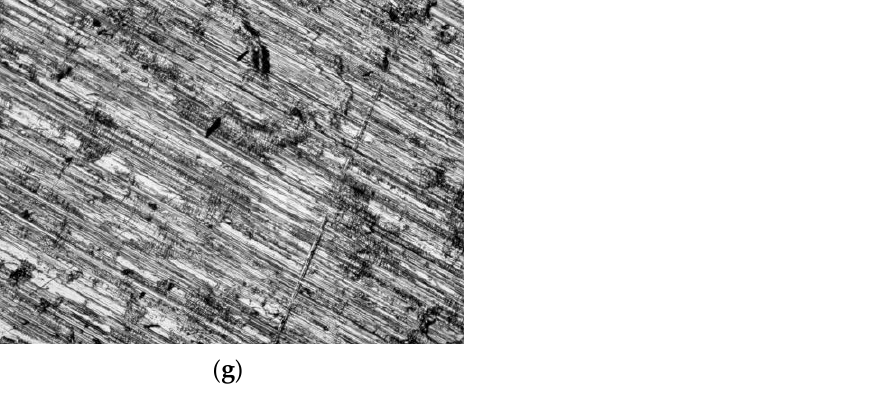
Figure 3. Optical micrographs (50µm) of abraded coatings after 2500 cycles ( a ) SG1 SD, ( b ) SG1 DD, ( c ) SG1 TD, ( d ) SG1.5 SD, ( e ) SG1.5 DD, ( f ) SG1.5 TD and ( g ) bare substrate .